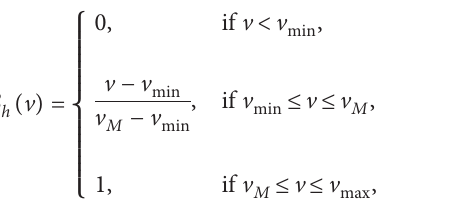
Figure 3: Membership function c